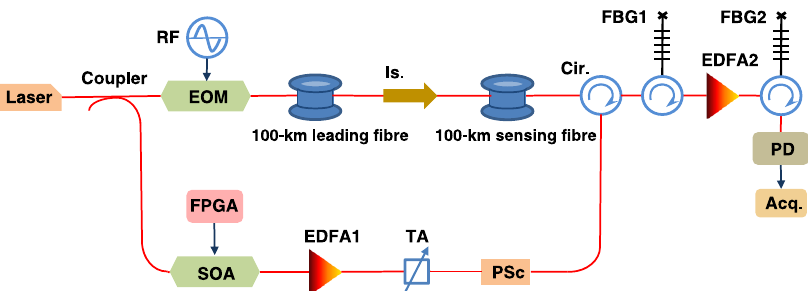
Fig. 6 Experimental setup for both GO-code and single-pulse BOTDA. RF radio frequency, EOM electro-optic modulator, Is. isolator, Cir. circulator, TA tuneable attenuator, PSc polarisation scrambler, SOA semiconductor optical ampli fi er, FBG fi bre Bragg grating, PD photodetector, Acq.